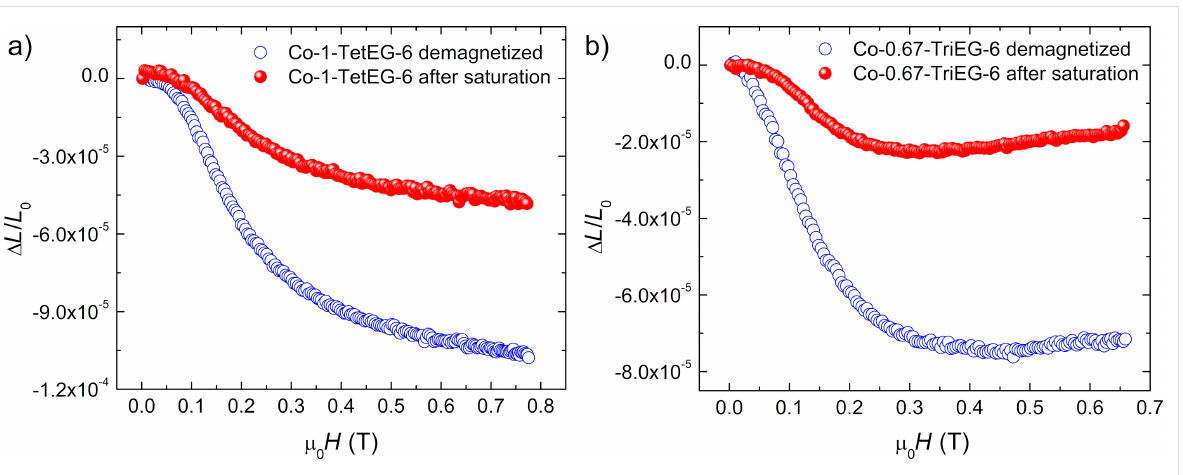
Figure 7: Radial magnetostriction as a function of the applied magnetic field for a) Co-1-TetEG-6 and b) Co-0.67-TriEG-6 consolidated derivatives, with measurements carried out from either the demagnetized (blue circles) or the in-plane saturated (red circles) state.